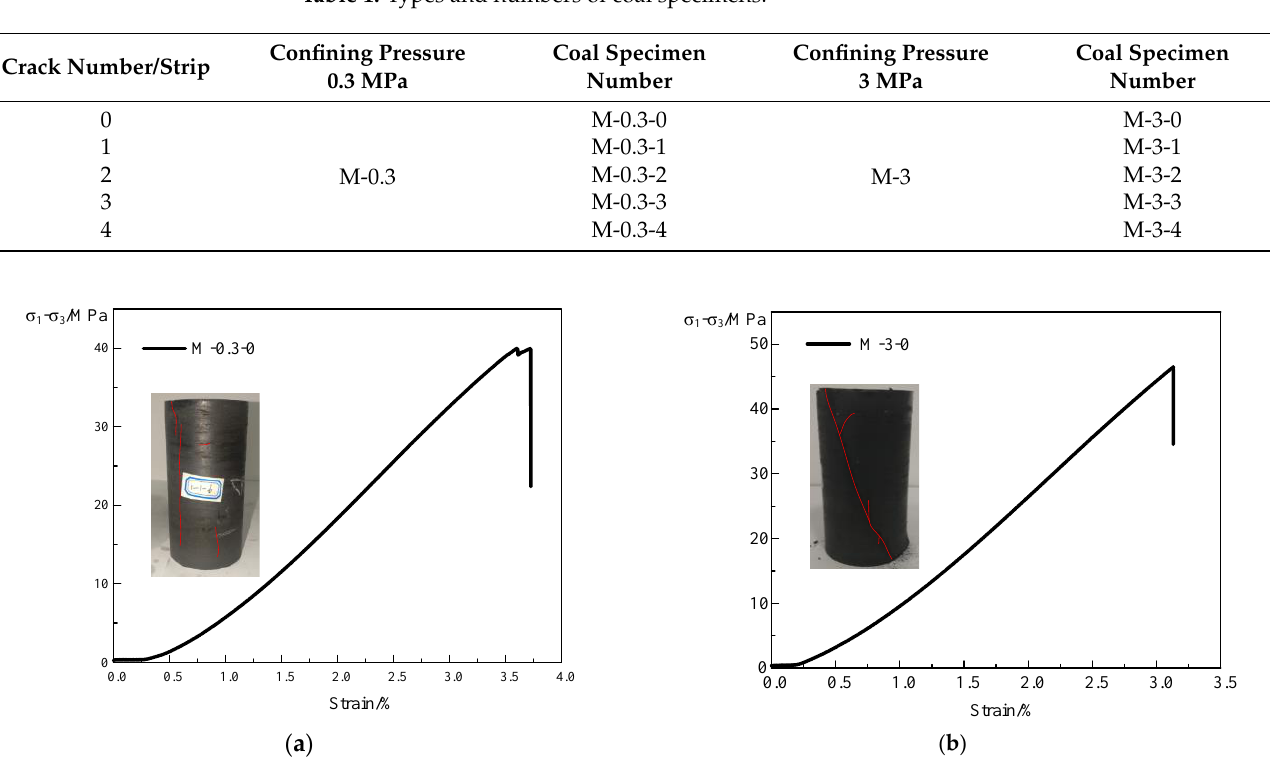
Figure 2. Complete coal specimen stress–strain curve. ( a ) Confining pressure 0.3 MPa; ( b ) confining pressure 3 MPa.